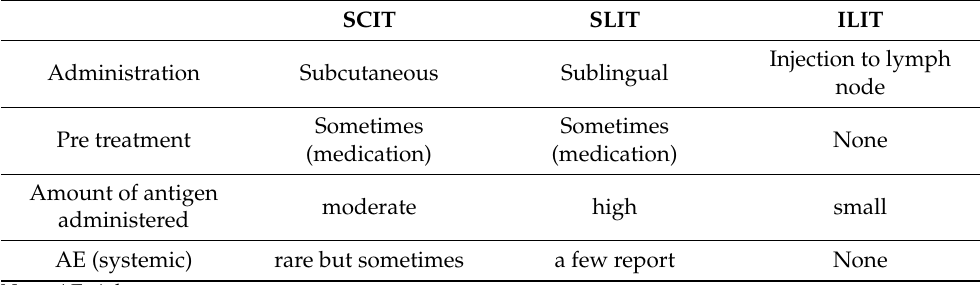
Table 1. Comparison among SCIT, SLIT, ILIT.